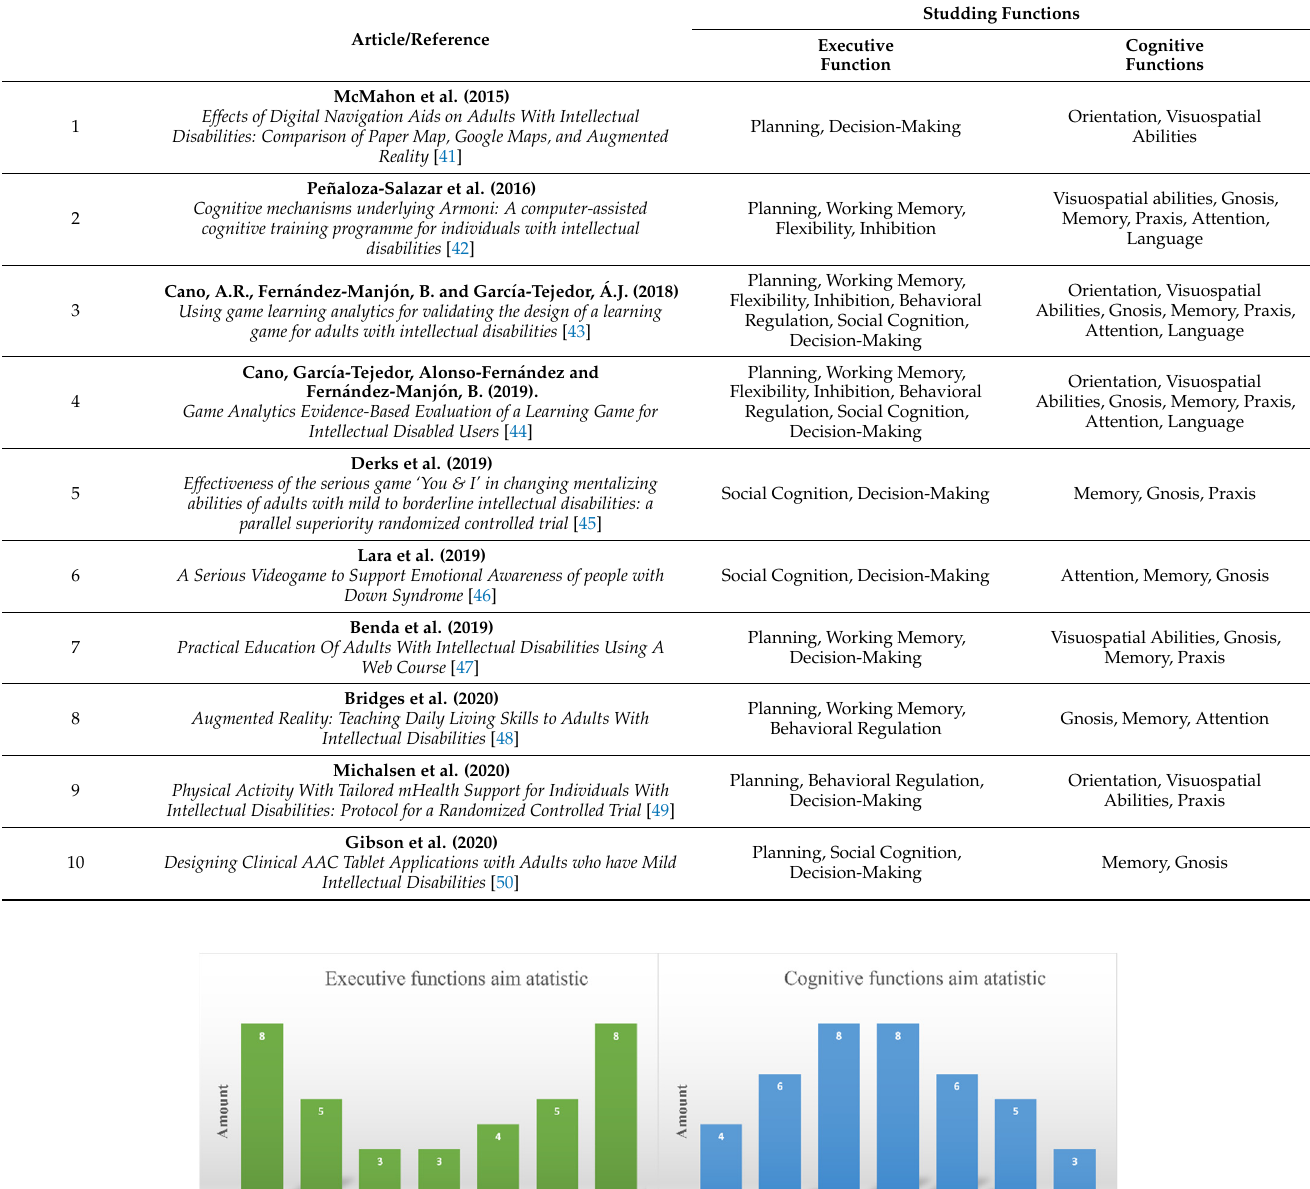
Table 6. Selected studies including executive and cognitive functions.